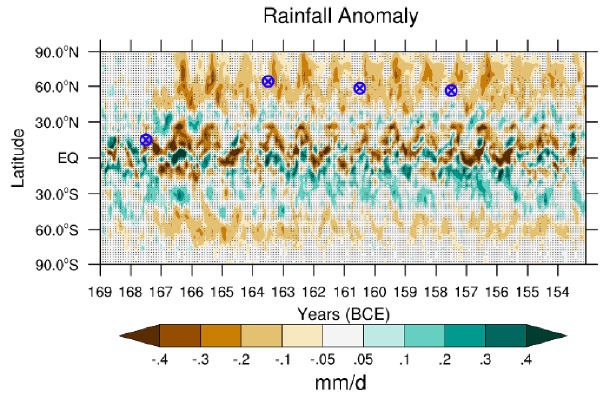
Figure 8. Hovmöller-type plot showing the zonally averaged rain- fall anomaly for the entire period as the spatiotemporal response of global rainfall to our series of volcanic eruptions. Circled cross marks show the locations and timing of the eruptions. Black dots point out regions where changes are not statistically significant at the 95% confidence